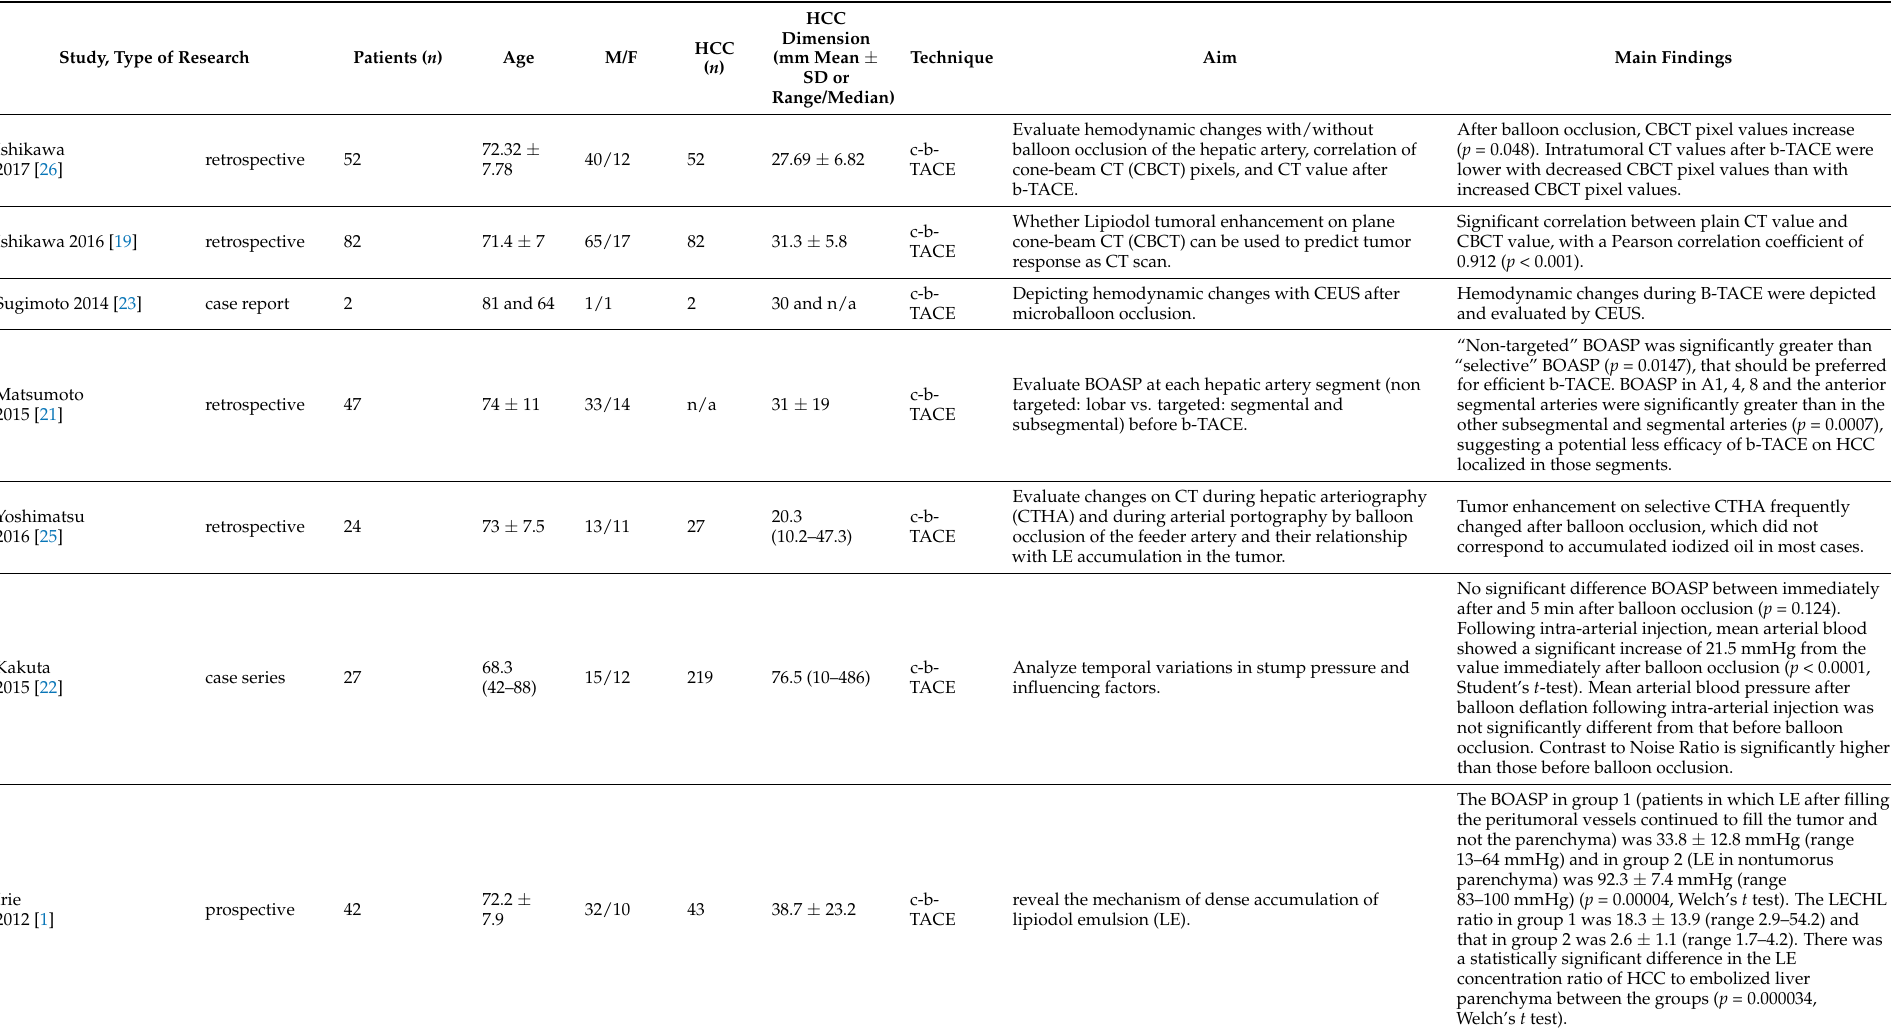
Table 1. Summaries of studies focused on demonstration of flow